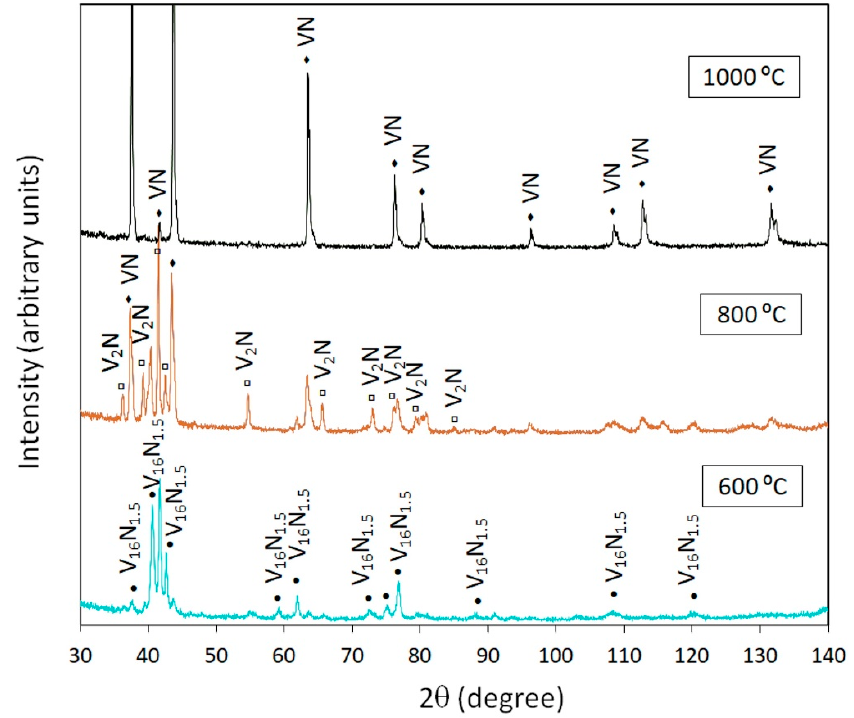
Figure 4. XRD patterns obtained for V powders nitrided under flowing NH 3 (1.14 mm·s − 1 ).